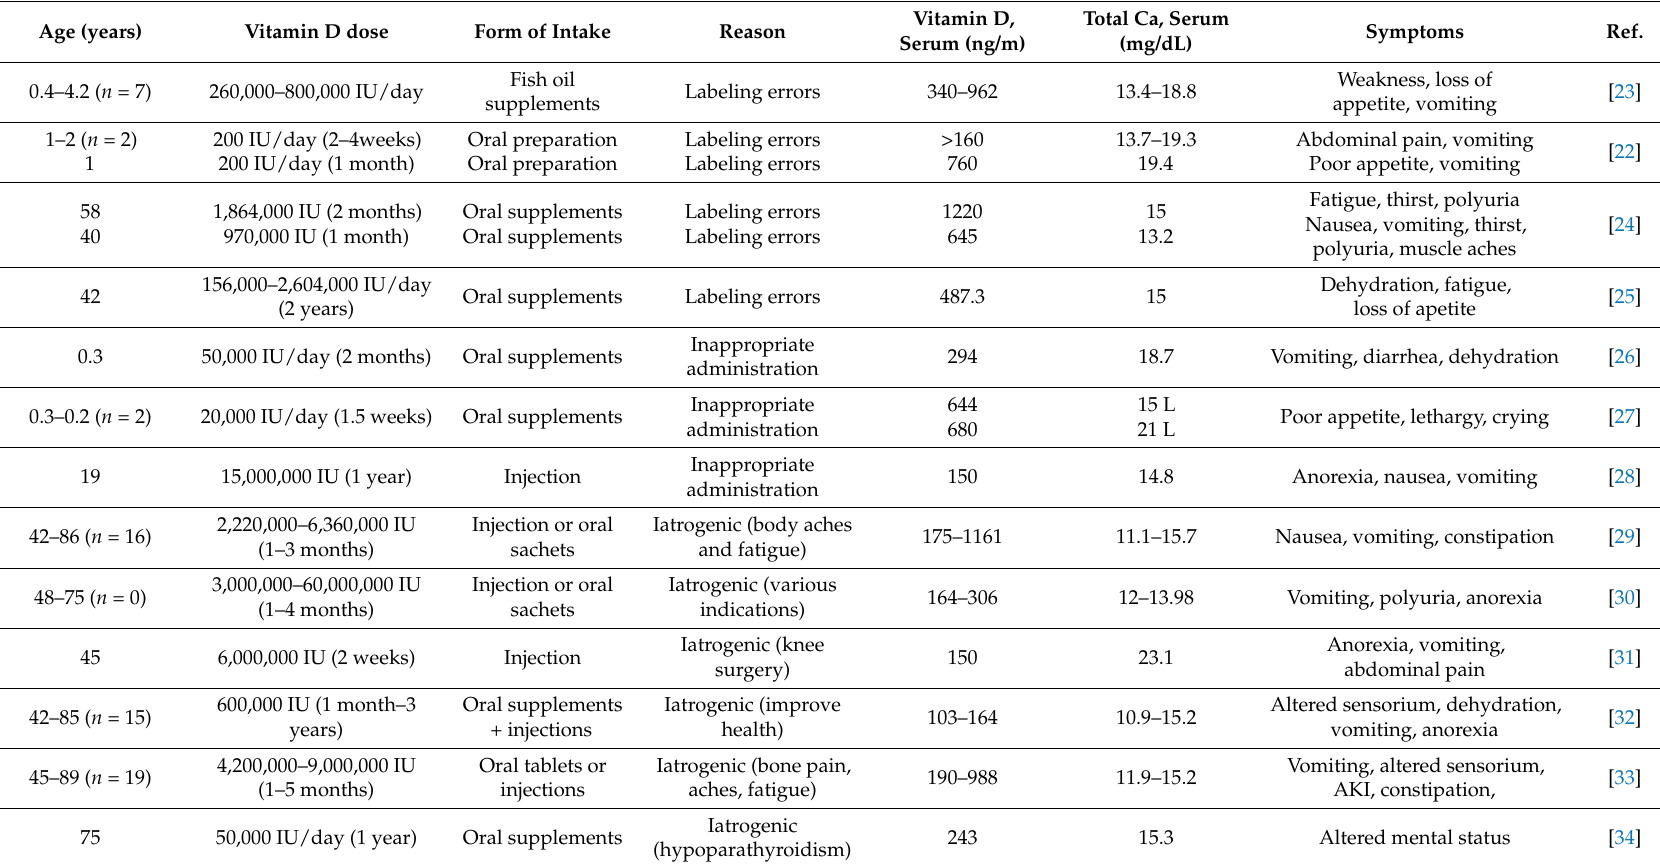
Table 1. Test results and dosage information of patients with vitamin D toxicity. AKI: acute kidney